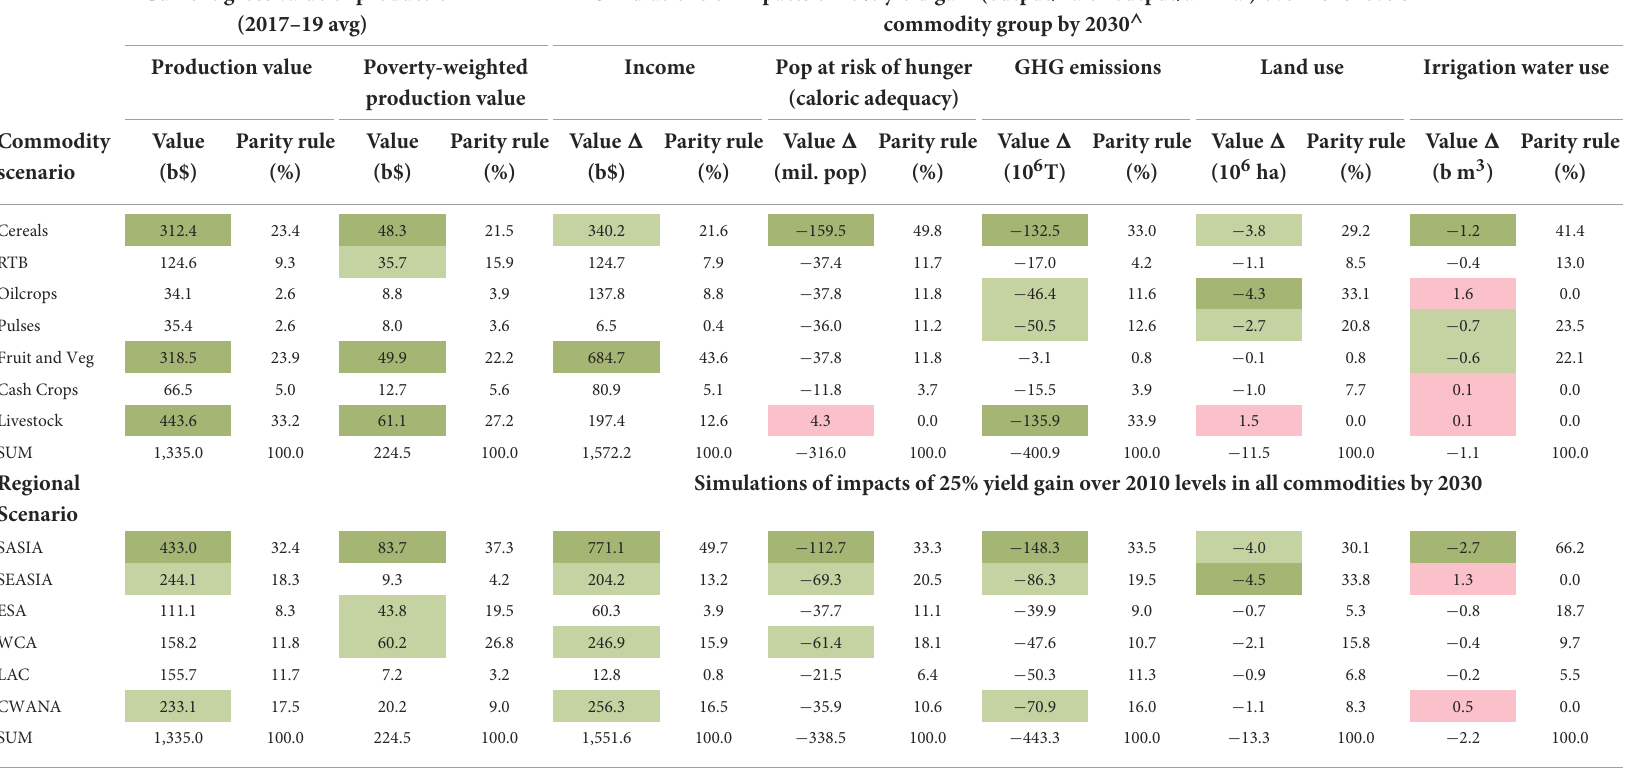
TABLE 3 Multi-dimensional impacts of increasing commodity and regional agricultural productivity in the target